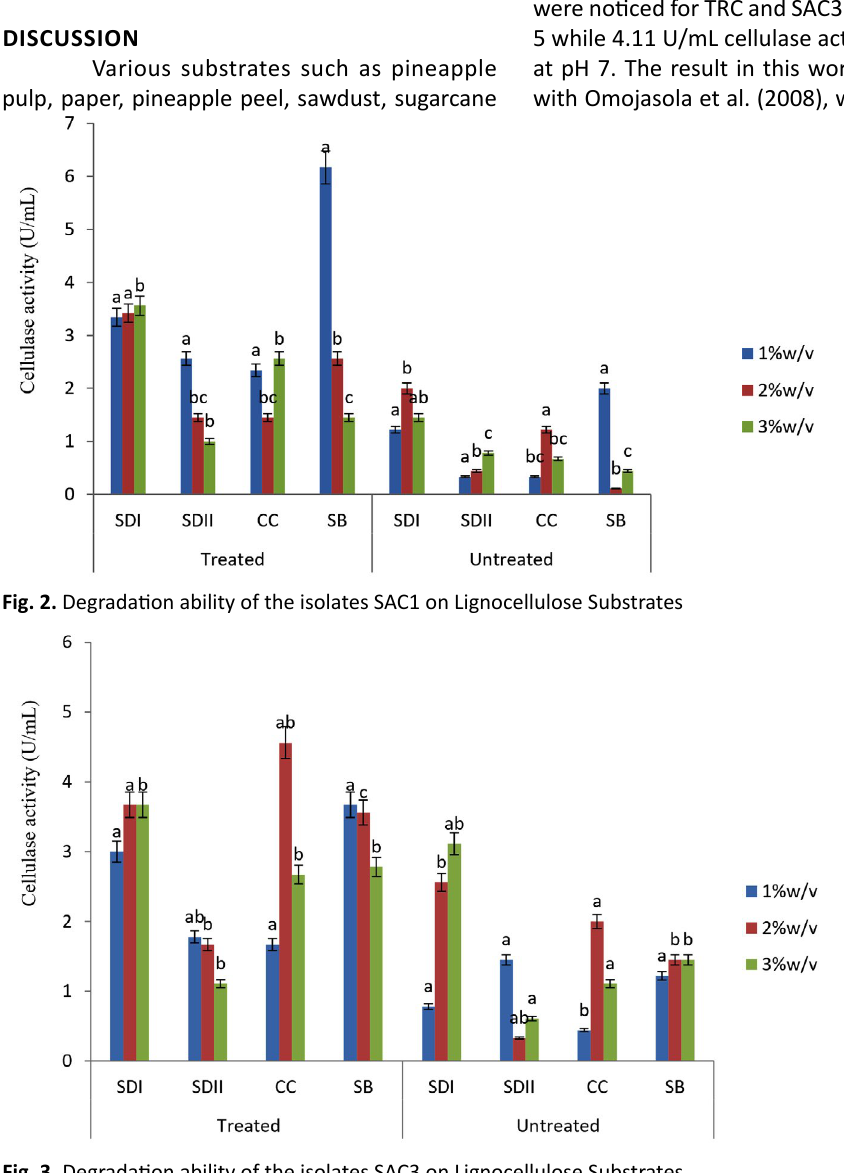
Fig. 3. Degradation ability of the isolates SAC3 on Lignocellulose